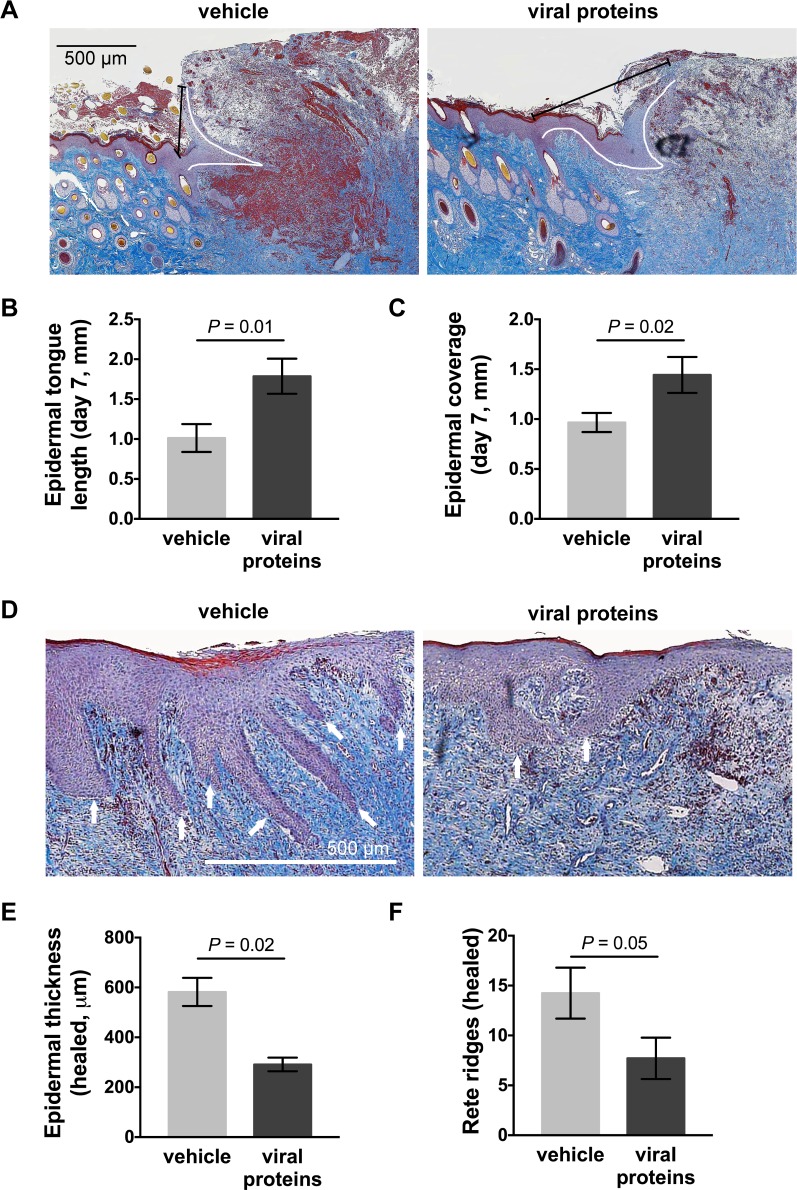
Epithelialisation of limb wounds of horses following treatment with viral proteins.(A) Representative photos of wound margin sections taken 7 days post-wounding, stained with MSB trichrome. White and black lines in each photo indicate the length of the epidermal tongue and epidermal coverage, respectively. (B) Epidermal tongue length and (C) epidermal coverage following topical administration of vehicle or viral proteins. (D) Representative photos of healed wounds stained with MSB trichrome. Rete ridges are indicated by white arrows. (E) Epidermal thickness (measured at 5 equidistant points across the neo-epidermis) and (F) number of epidermal rete ridges projecting into the neo-dermis of healed wounds following administration of vehicle or viral proteins. Values represent mean ± SEM, n = 4. P values indicated were determined using a two-tailed ratio paired t-test.